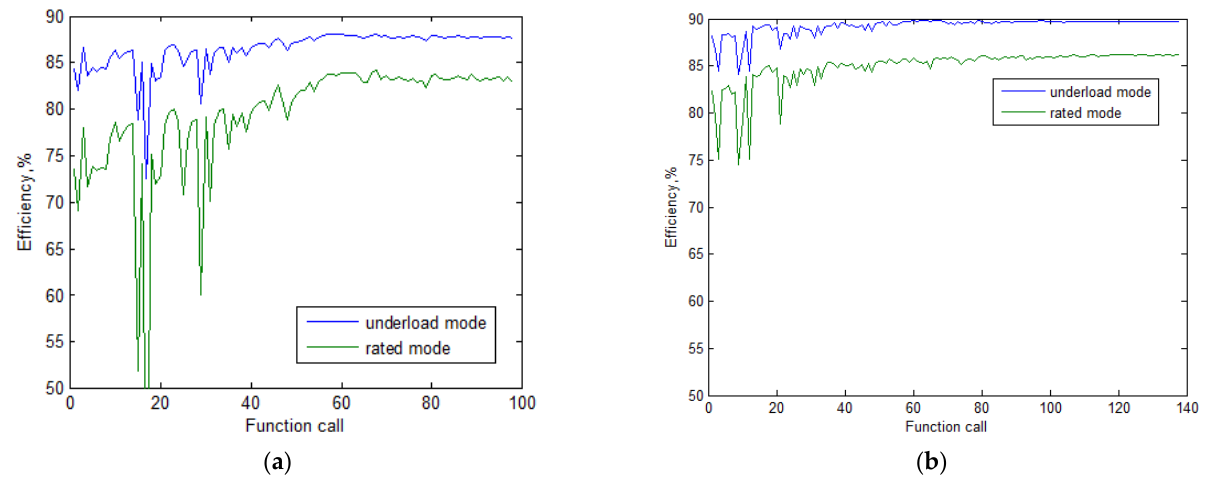
Figure 6. The change in efficiency during optimization. ( a ) PMFSG; ( b ) IPMSG.